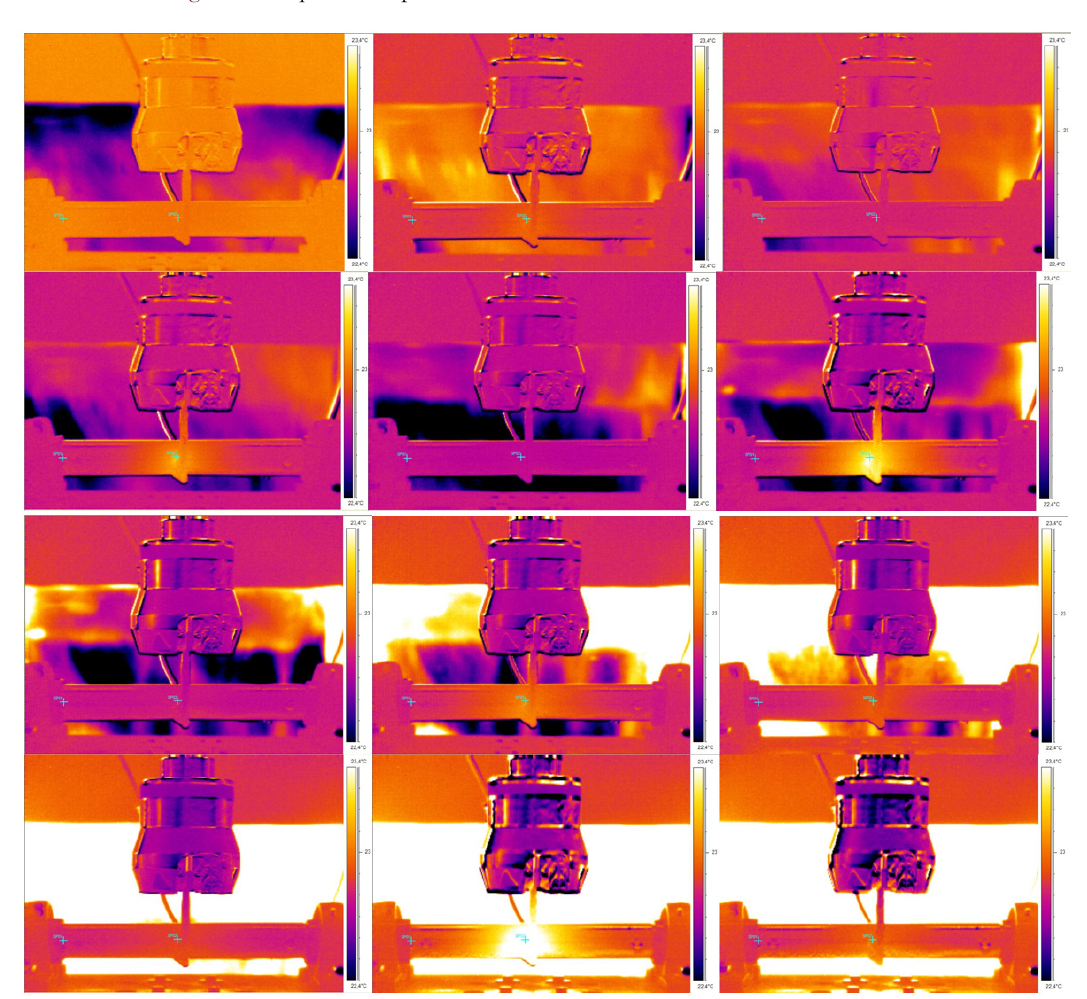
Figura 14: Immagini termiche relative alle dodici fasi di Fig.